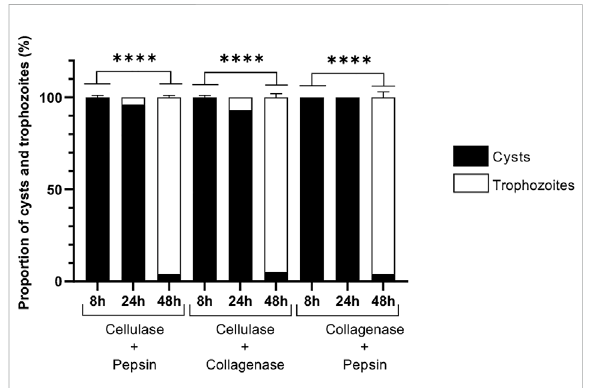
FIGURE 4 Effect of enzyme combinations on Acanthamoeba castellanii excystment. Proportions of A. castellanii trophozoites and cysts observed following 8, 24 and 48 h of treatment by enzyme associations at 30 ° C. In these associations, all enzyme concentrations were at 5 U/mL. The results correspond to the mean of three independent experiments ±SD.